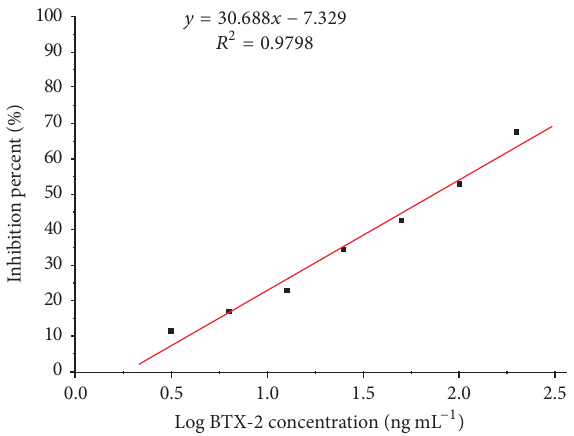
Figure 5: Plot of the indirect competitive ELISA of the BTX- 2 aptamer Bap5. The calibration curve was obtained with the inhibition percent [(𝑁 − 𝑆)/𝑁 × 100 % ] on the 𝑦 -axis and the log concentration of BTX-2 on the 𝑥 -axis. The 𝑁 and 𝑆 values were the OD 492 of the control and the sample, respectively. As the concentration of the BTX-2 standard increased (ranging from 3.125 to 200 ng mL −1 ), the inhibition ratio ranged from 11.67% to